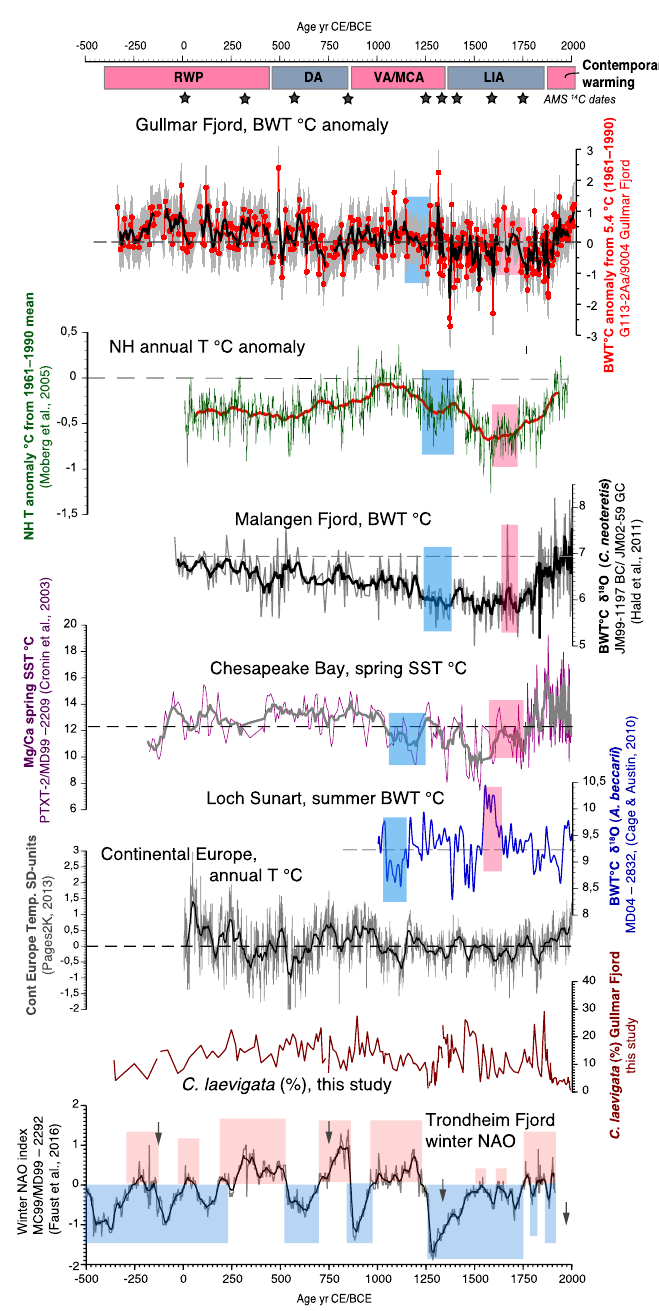
Figure 6. Reconstructed bottom water temperatures (BWT) shown as an anomaly against the 1961–1990 instrumental mean of 5.4 ◦ C from Gullmar Fjord and compared against other temperature proxy records: annual Northern Hemisphere temperatures (Moberg et al., 2005), bottom water temperatures from Malangen Fjord in north-western Norway (Hald et al., 2011) and Loch Sunart in Scotland (Cage and Austin, 2010), spring sea surface temperatures from Chesapeake Bay, eastern North Atlantic Ocean (Cronin et al., 2003), annual temperatures reconstructed for continental Europe (PAGES 2K, 2013) and the reconstructed NAO record from Trondheim Fjord, western Norway (Faust et al., 2016). Also shown, are relative abundances of foraminifer Cassidulina laevigata in the fjord with abundance minima and respective gaps in temperature reconstruction linked to the positive NAO index (arrows). For the locations of these proxy records see Fig. 1a and for abbreviations see the caption of Fig. 5. Grey shaded areas in the Gullmar Fjord BWT anomalies indicate a median offset (0.7 ◦ C) in instrumental versus reconstructed temperatures (see Fig. 4a) obtained for Rose Bengal stained C. laevigata from the core tops, used herein as an error margin. Blue and pink boxes depict a short-lived cooling at ∼ 1250CE and a warm interval between ∼ 1570 and 1700CE, respectively (as discussed in the